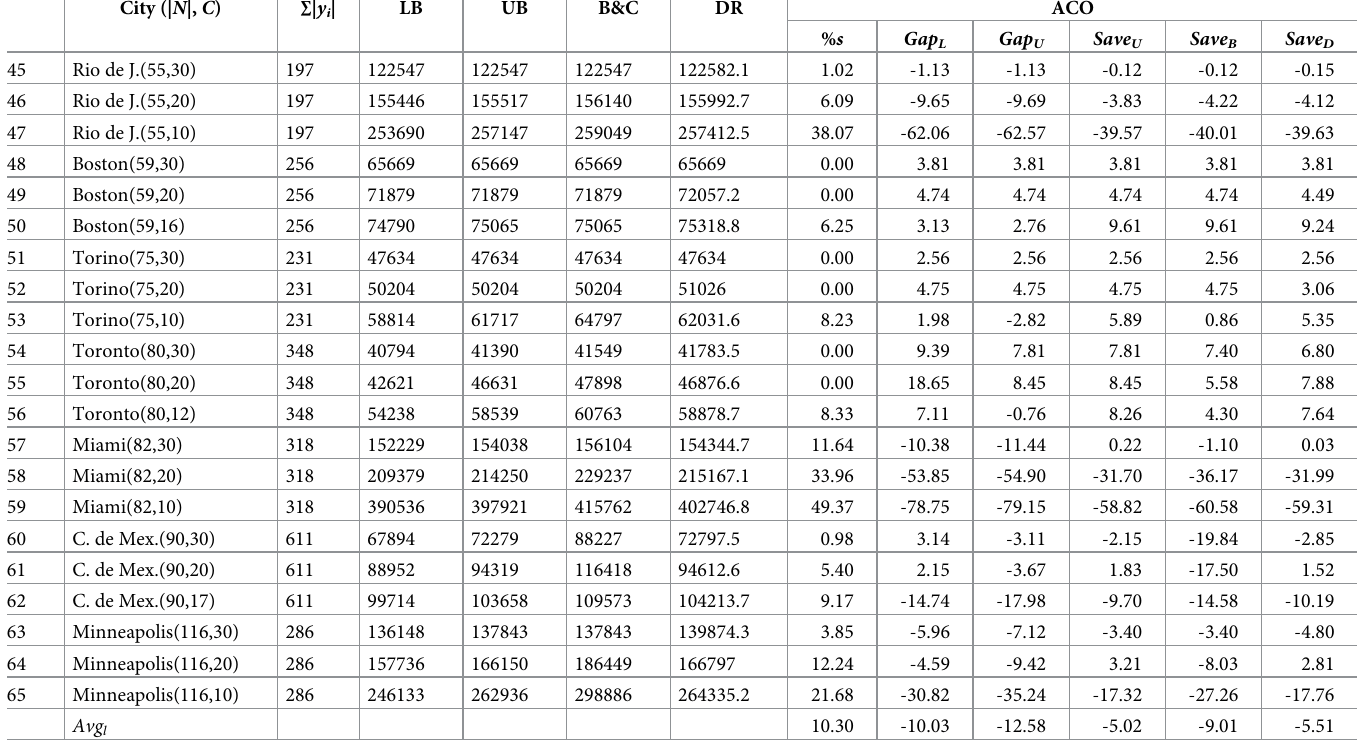
Table 3. Computational results for large-size